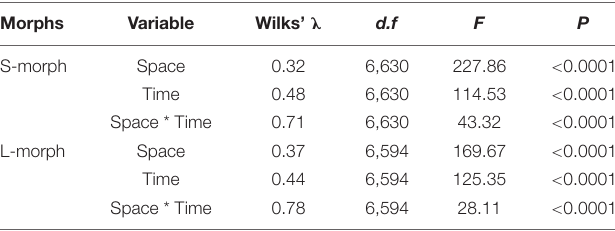
TABLE 1 | Multivariate analysis of variance of the effects of the site (space), flowering phase (time), and their interaction on the overall floral traits of L- and